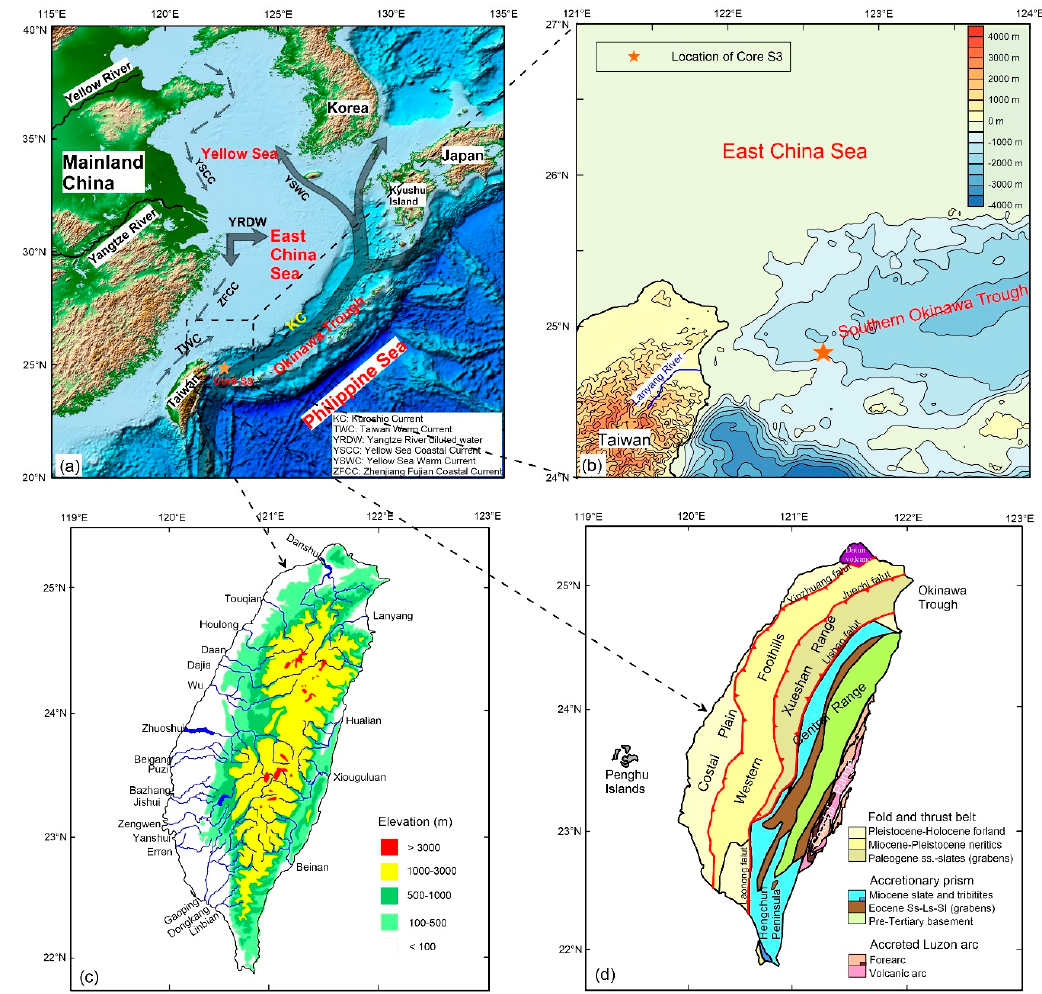
Figure 1. Map of the study area showing the location of Core S3 ( a, b ; ocean currents modified after Reference [38]), the major hydrographic network in Taiwan Island ( c ; modified after Reference [44]), and the tectonic map of Taiwan Island ( d ; modified after Reference [45]).